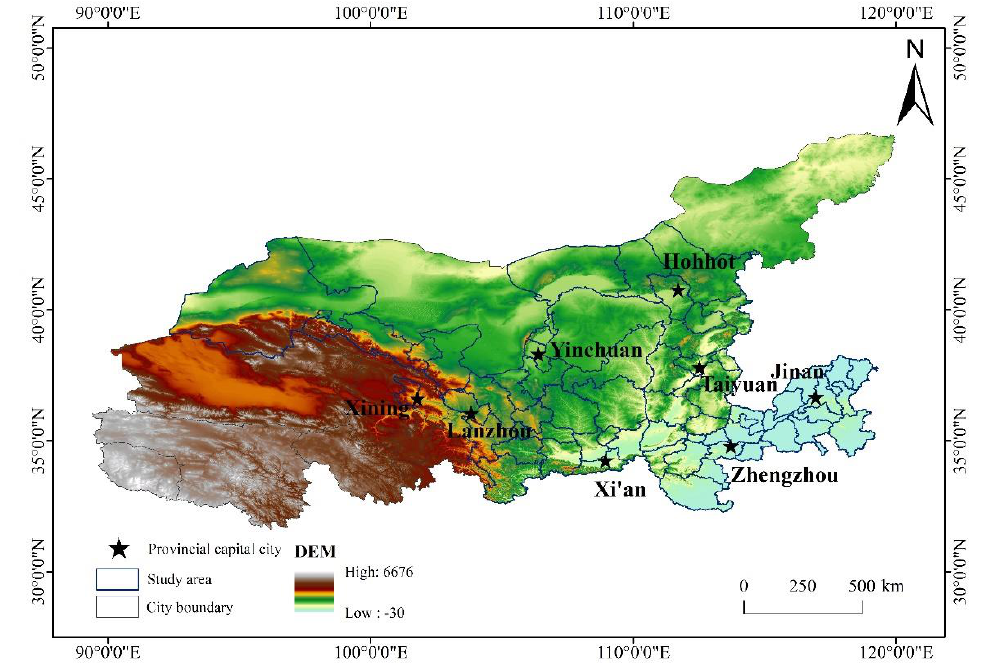
Figure 1. Geographical location of the study area, Yellow River Basin, China.